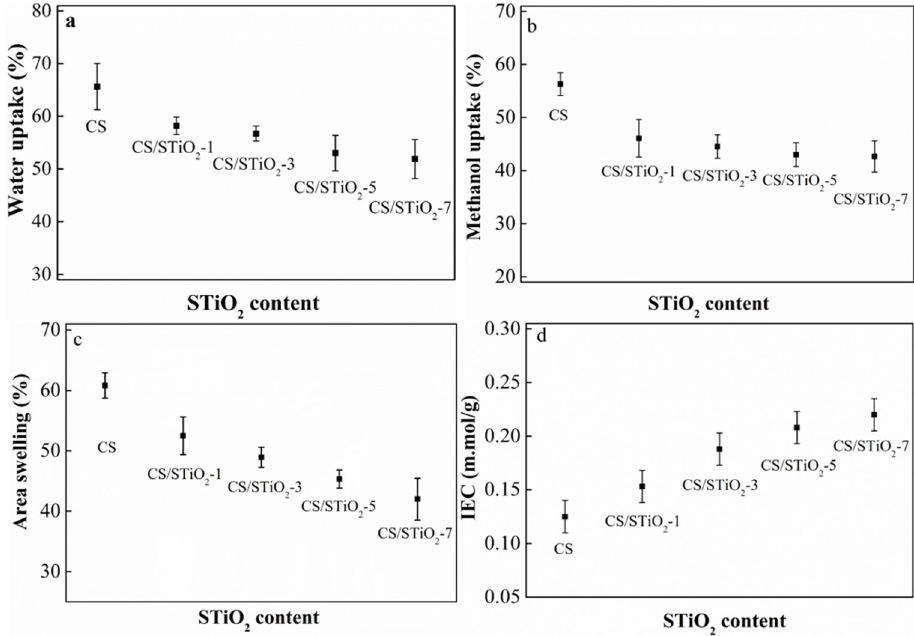
Figure 7. Water uptake ( a ), methanol uptake ( b ), area swelling ( c ) and IEC of CS control and CS/STiO 2 nanocomposite membranes at room temperature ( d ) .